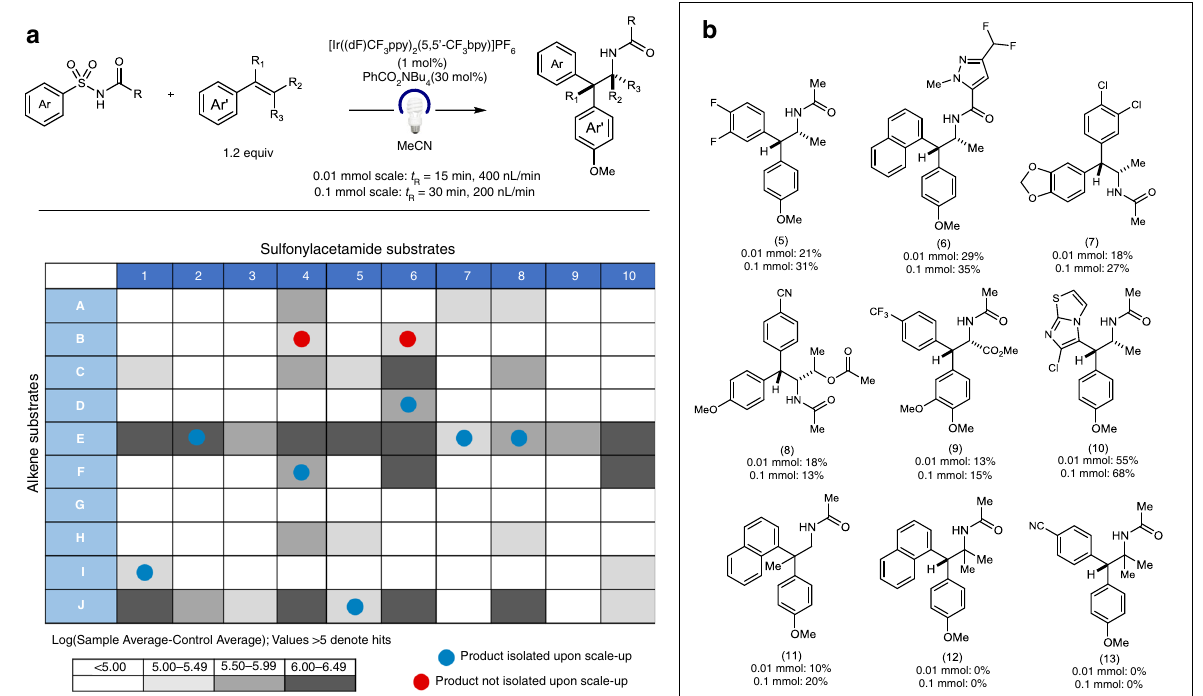
Fig. 3 Droplet micro fl uidics-enabled HTE reaction discovery on the picomole scale. a Heatmap of coupling 10 sulfonylacetamides with a matrix of 10 alkene substrates. Gray boxes denote potential hit/hit responses. Boxes containing red and blue circles indicate reactions that were performed on 0.01 mmol and 0.1 mmol scale. b Product yields for millimole scale-up fl ow reactions. [Ir((dF)CF 3 ppy) 2 (5,5 ′ -CF 3 bpy)]PF 6 4,4 ′ -di- tert -butyl-2,2 ′